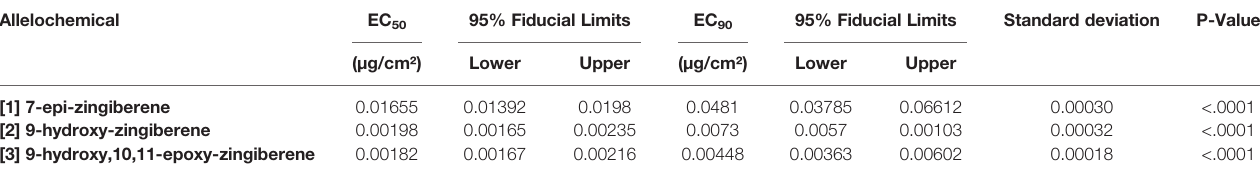
TABLE 3 | EC 50 and EC 90 values (μg/cm² of fi lter paper) and their 95% fi ducial limits, standard deviations, and P values of three allelochemicals ([1], [2], and [3]) isolated by silica gel chromatography and tested in the bridge bioassay. Allelochemical